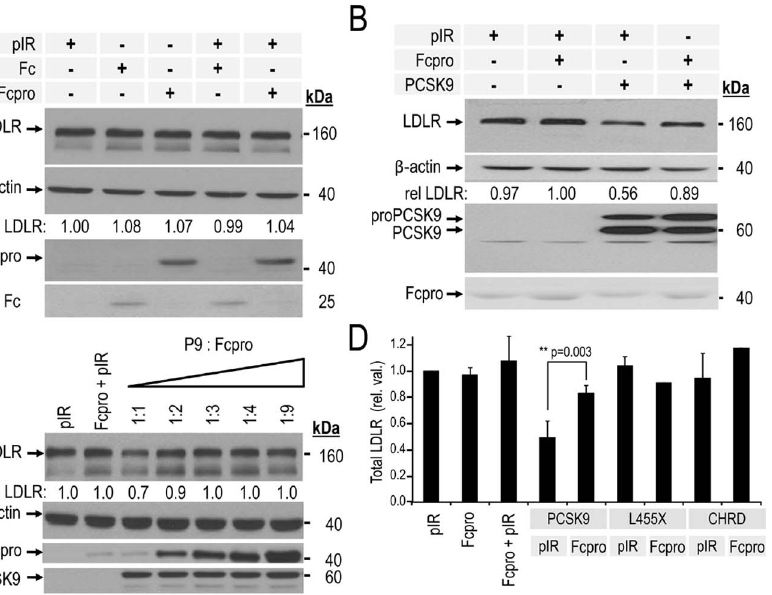
Figure 2. Intracellular trans -acting inhibitory effect of Fcpro on PCSK9 capacity to induce LDLR degradation. HepG2/shPCSK9 cells were co-transfected: A – D ) with an empty pIRES vector (pIR) or human IgG1 fragment crystallizable region (Fc), both as negative controls; with the wild type human PCSK9; PCSK9 lacking CHRD (L455X); the CHRD alone, or the PCSK9 prosegment fused to Fc (Fcpro). C ) Cells were co-transfected with wild type human PCSK9 and increasing ratios of Fcpro. Cell lysates were resolved by 12% SDS-PAGE and proteins analyzed by Western blot. B , D ) Total LDLR was detected using a polyclonal anti-human LDLR and its levels were normalized relative to b -actin cellular loading controls. Fc and Fcpro proteins were detected using a polyclonal anti-Fc antibody. PCSK9, L455X and CHRD proteins were detected using a monoclonal anti-V5 antibody. Statistical values were estimated by Student’s t-test and considered significant when p-values were , 0.05. The data show that co-expression of Fcpro with PCSK9 significantly reduces its capacity to induce LDLR degradation (**p=0.003). These data are representative of at least three independent experiments.